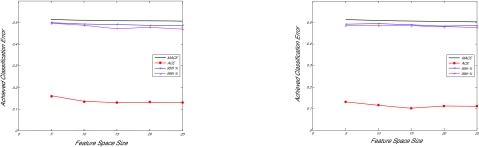
PACE analysis using a SVM-based classifier using the weighted separability scoring criterion, with a 0.6 MAC threshold. Left Panel: performance without peak selection. Right panel: performance with peak selection.